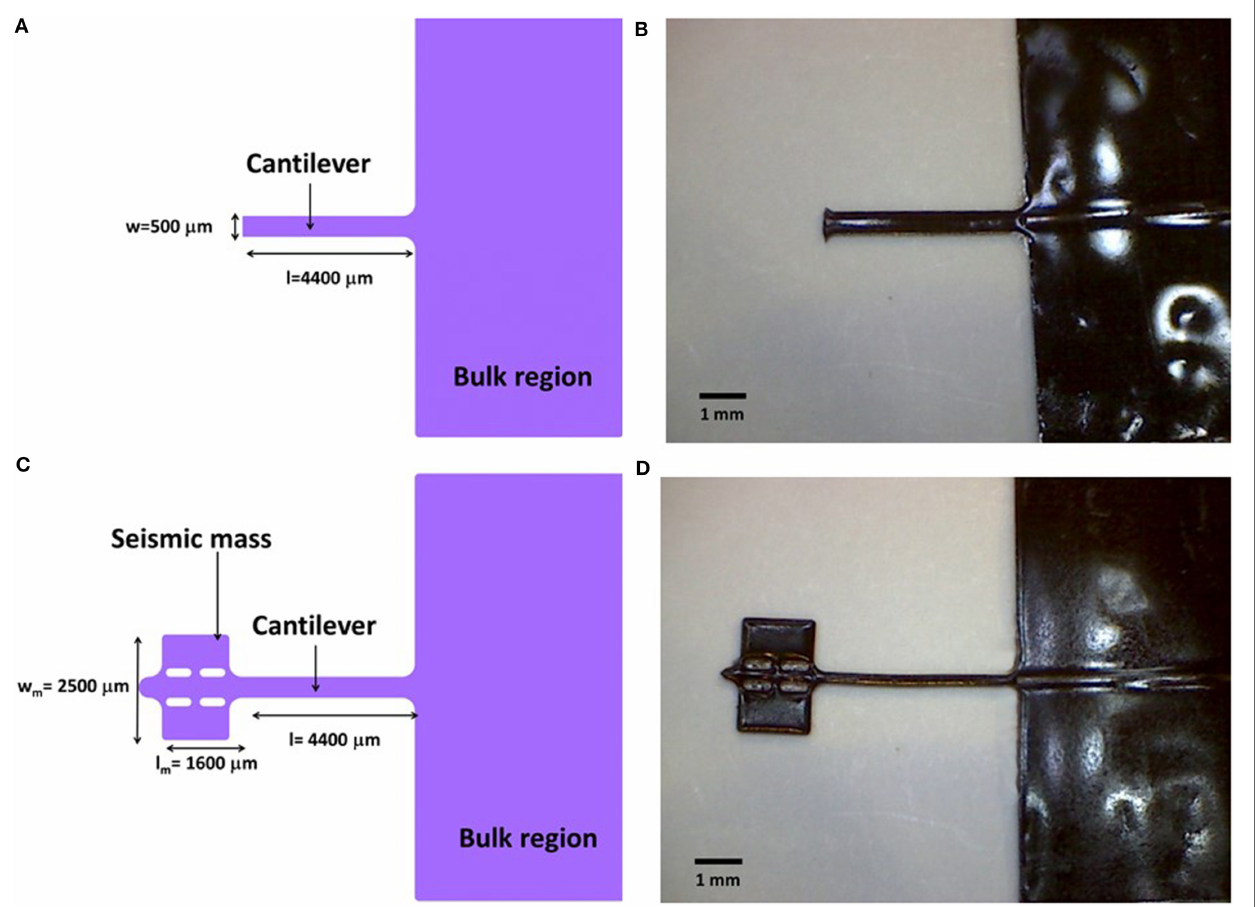
FigUre 1 | (a) Design and (B) fabricated cantilevers using M-SRE for measurement of the Young’s modulus using S 5 M-SRE. (c) Design and (D) fabricated soft microsystems using the same material. In both cases, the thickness of the structures was of 250 μ